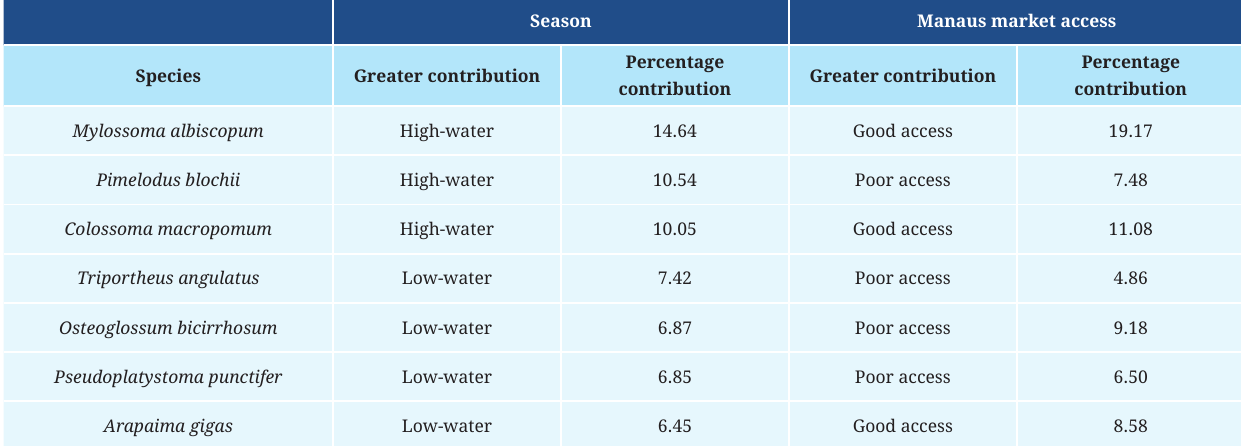
TABLE 2 | The fish species that contribute most to the variation in catch biomass between seasons and levels of urban access (with the city of Manaus) – SIMPER analyses. Access to the Manaus market is largely defined by the visitation of fish-buyer boats from Manaus, as most fishers without this are unable to gain regular access to the Manaus market. Refer to Tabs. S4 and S5 for full